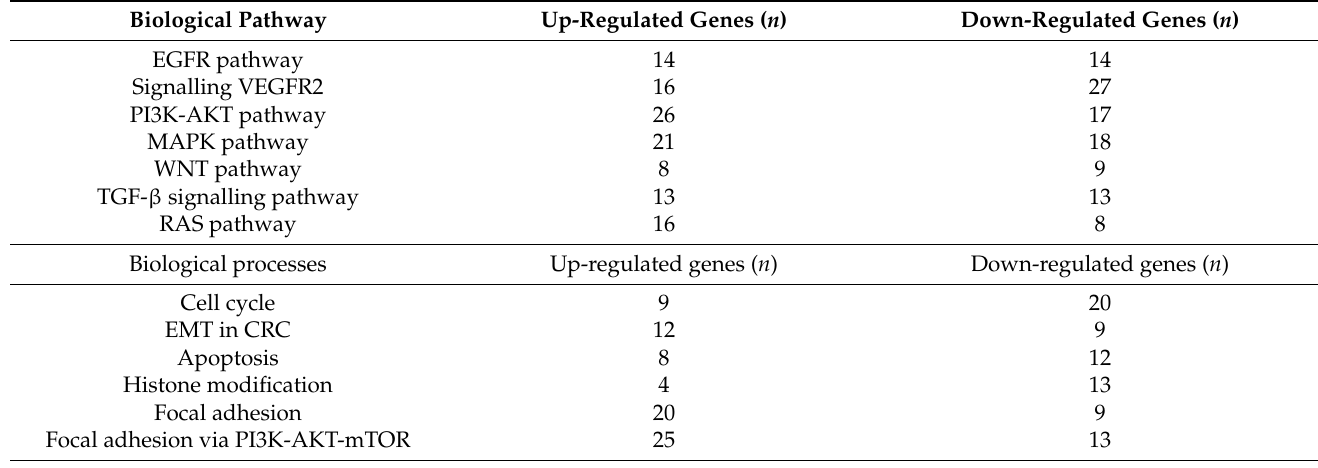
Table 1. Gene ontology of the alterations induced in the transcriptome of DLD1 and HCT116 cells by silencing the ZNF518B